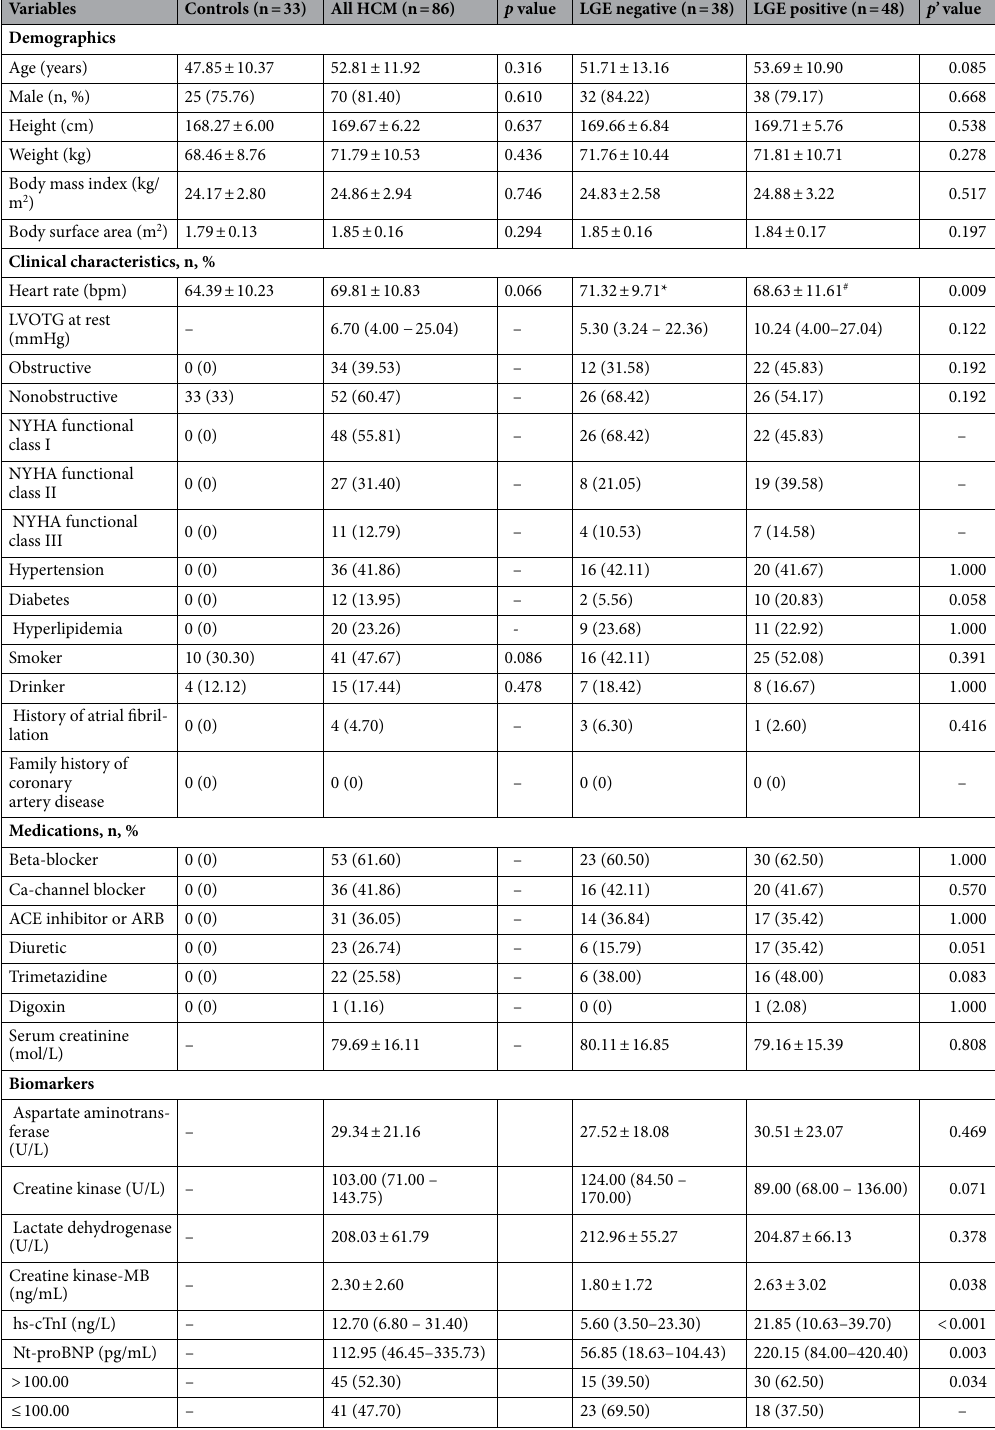
Table 1. Demographic and clinical characteristics of the study population. Values expressed as n (%) or mean ± SD or median (interquartile range). The p values reflect the comparison between 2 groups (controls vs. All HCM). The p’ values reflect the comparison between 3 subgroups (controls vs. LGE (−) vs. LGE ( +)) or 2 subgroups (LGE (−) vs. LGE ( +)), respectively. LGE, late gadolinium enhancement; LVOTG, peak left ventricular outflow tract gradient; NYHA, New York heart association; ACE, angiotensin-converting enzyme; ARB, angiotensin-receptor blocker; Nt-proBNP, N-terminal pro b-type natriuretic peptide; hs-cTnI, high- sensitivity cardiac troponin I. * < 0.05 vs. controls. # < 0.05 vs. LGE